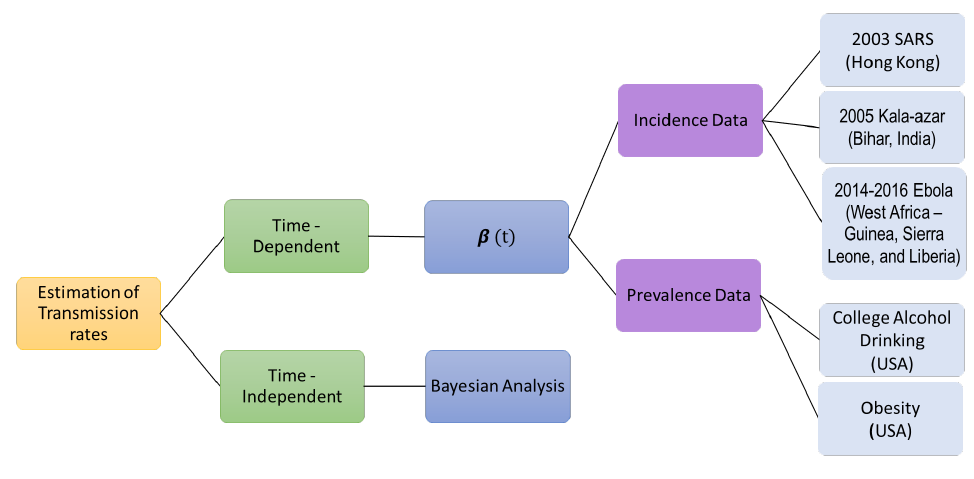
Figure 1. Overview of the paper.